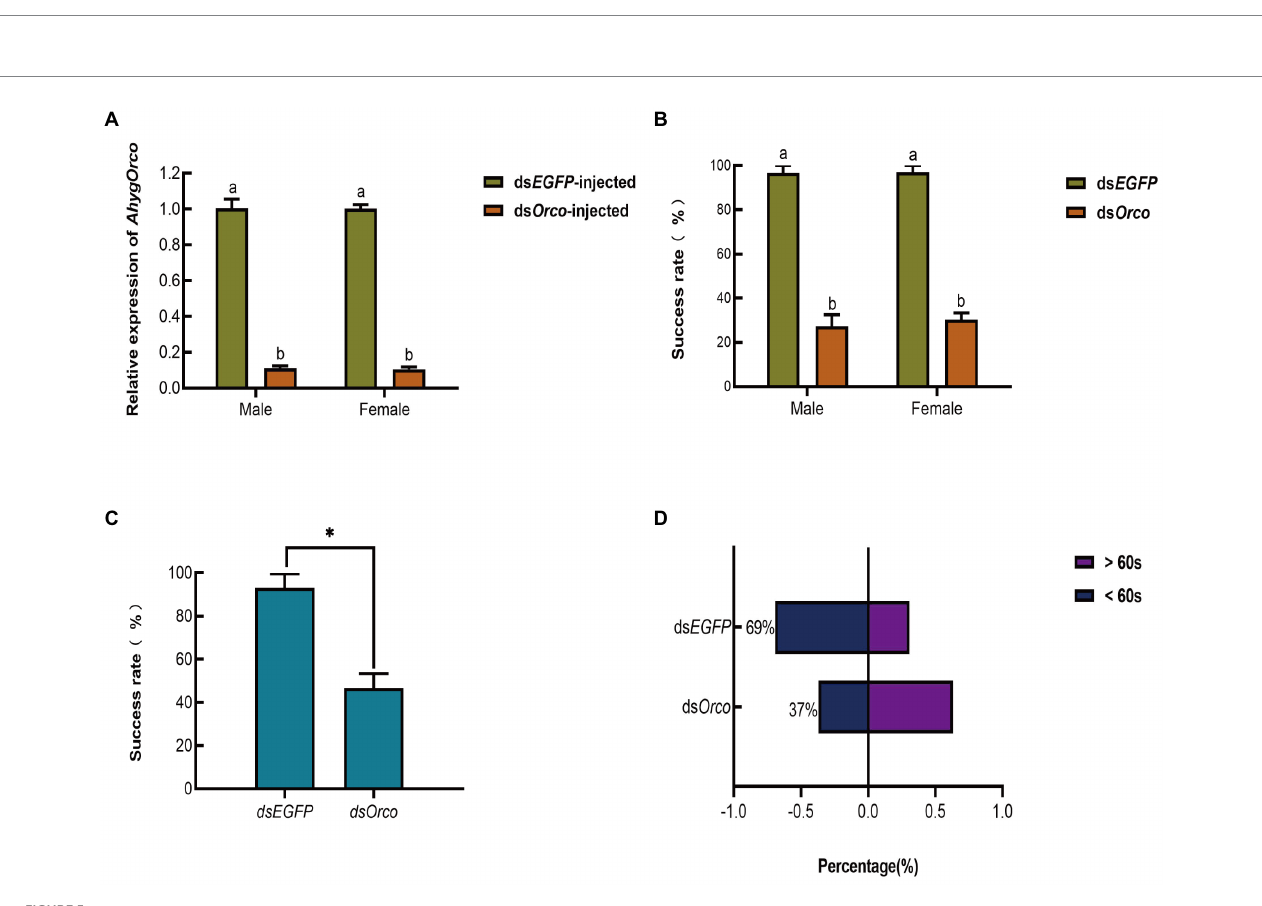
FIGURE 5 (A) Validation of AhygOrco transcript levels in ds Orco -injected and ds EGFP -injected A. hygrophila . The transcript level of AhygOrco was normalized to the RPL13a control gene. The values marked with different letters are significantly different based on Mann–Whitney U test (Male: Z = − 1.964, p < 0.05; Female: Z = − 1.964, p < 0.05). Data are presented as the mean (n = 3) ± SEM. (B) The percentage of individuals who successfully found A. philoxeroides within 2 min. (Mann–Whitney U test, Male: Z = − 1.993, p < 0.05; Female: Z = − 1.993, p < 0.05). (C) The percentage of individuals who successfully found a mate within 60 s. (Mann–Whitney U test, Z = − 1.993, p < 0.05) Data are presented as the mean ( n = 3) ± SEM. (D) The time these individuals spent searching. ds EGFP , insects injected with dsRNA against EGFP . ds Orco , insects injected with dsRNA against AhygOrco